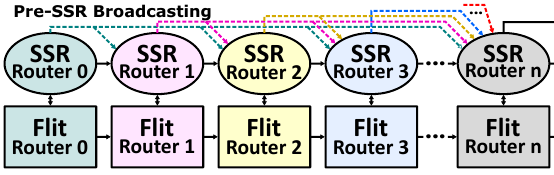
Figure 2. Architecture of SMART NoC with SSR